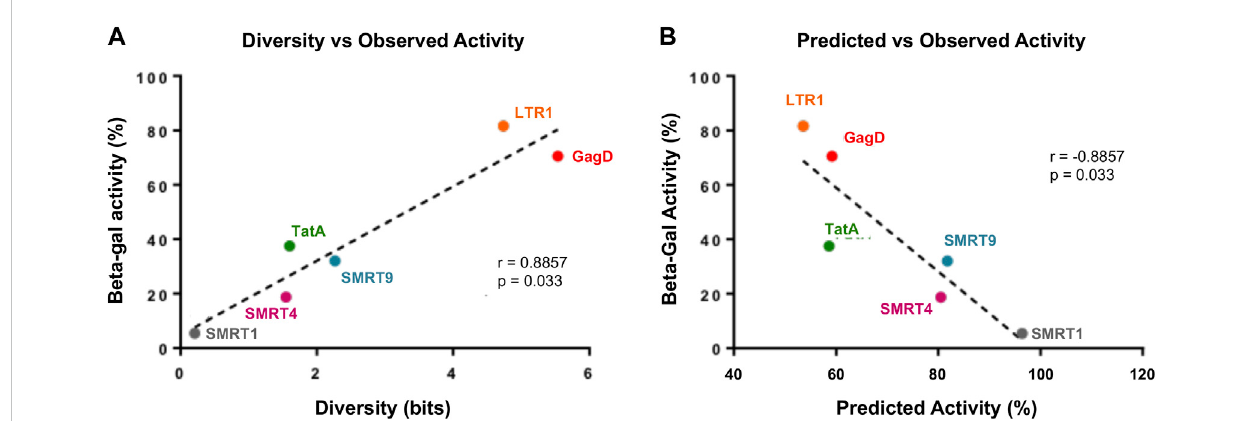
FIGURE 8 There is a strong correlation with gRNAs that target highly conserved regions and have high predicted activity pro fi les. Reporter expression data was taken from Figure 6. Observed activity was calculated by taking the average RLU from the three independent experiments. (A) Diversity was calculated for each gRNA position, details on how this was performed has been provided in the Materials and Methods. Observed activity was plotted against diversity, the dotted line representedtheregressionintheline. (B) PredictedactivitywasmeasuredforeachgRNA,adetailedbreakdownofthiscalculationhasbeenmadeavailablein the Materials and Methods. Observed activity was plotted against predicted activity, dotted line represents the regression of the